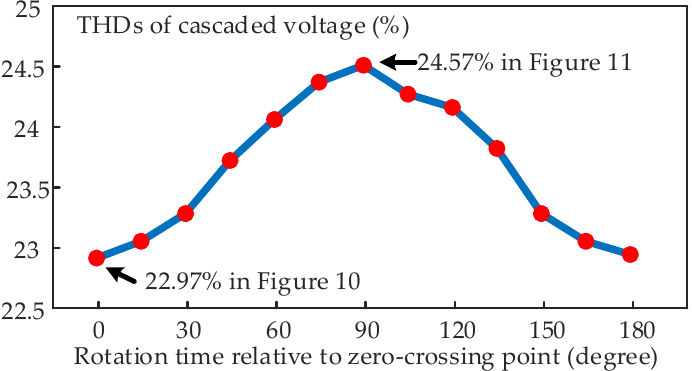
Figure 12. THDs of the cascaded output voltage with different asynchronous rotation time and carrier ratio K = 2. ratio K =